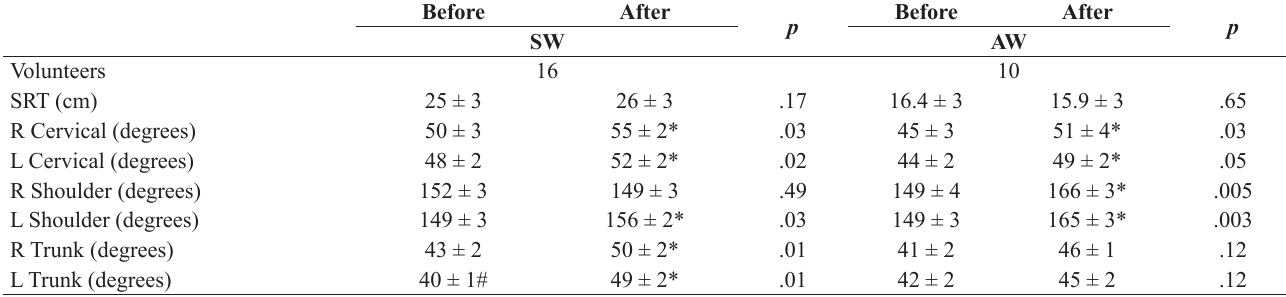
Table 5. Flexibility before and after the 6-month stretch break program.